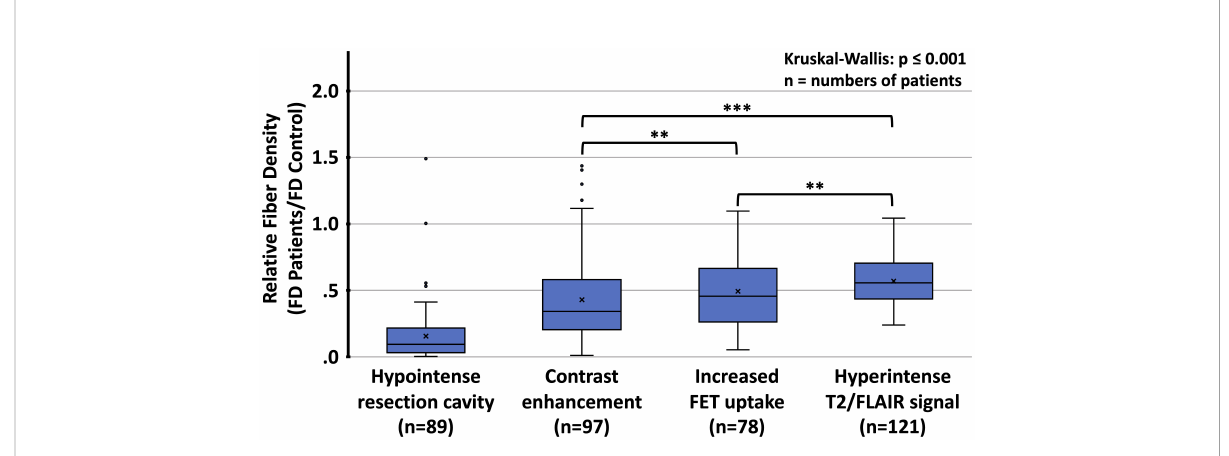
FIGURE 5 Distribution of relative fi ber densities (fraction of fi ber density (FD) of the corresponding region in healthy controls) for the respective imaging fi ndings. FET, O-(2-[ 18 F] fl uoroethyl)-L-tyrosine; T2/FLAIR, T2-weighted fl uid-attenuated inversion recovery (FLAIR) hyperintense lesions; **p<0.01, ***p<0.001, Mann-Whitney U test for comparison between different types of